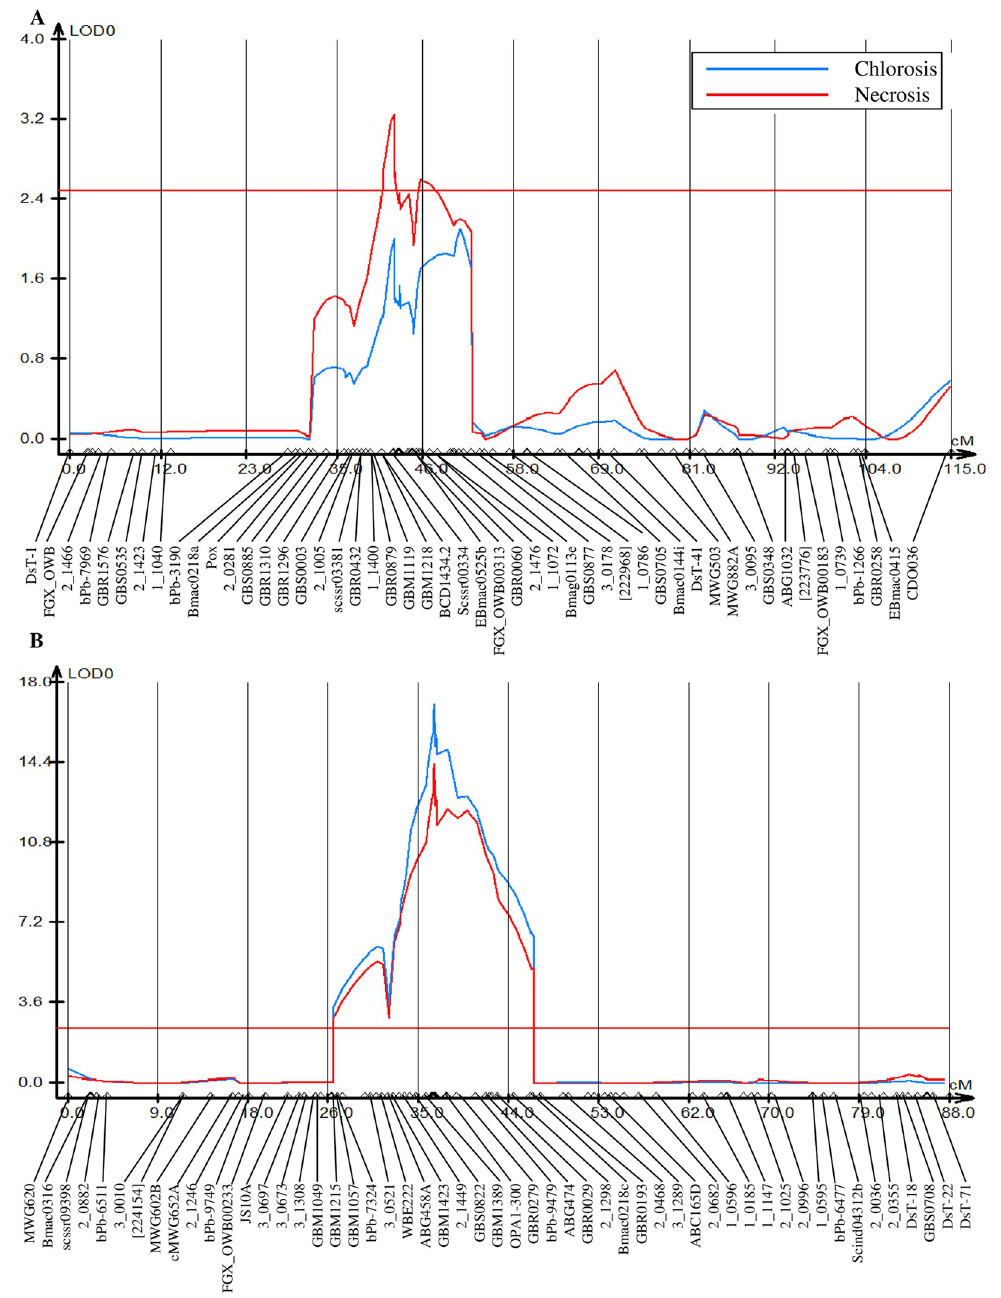
Fig 2. QTL scanning curves for the chlorosis and necrosis in the OWB population. QTL curves on chromosomes (A) 2H and (B) 6H of the OWB population. The horizontal axis represents the position of markers. The vertical axis represents the LOD score. R: